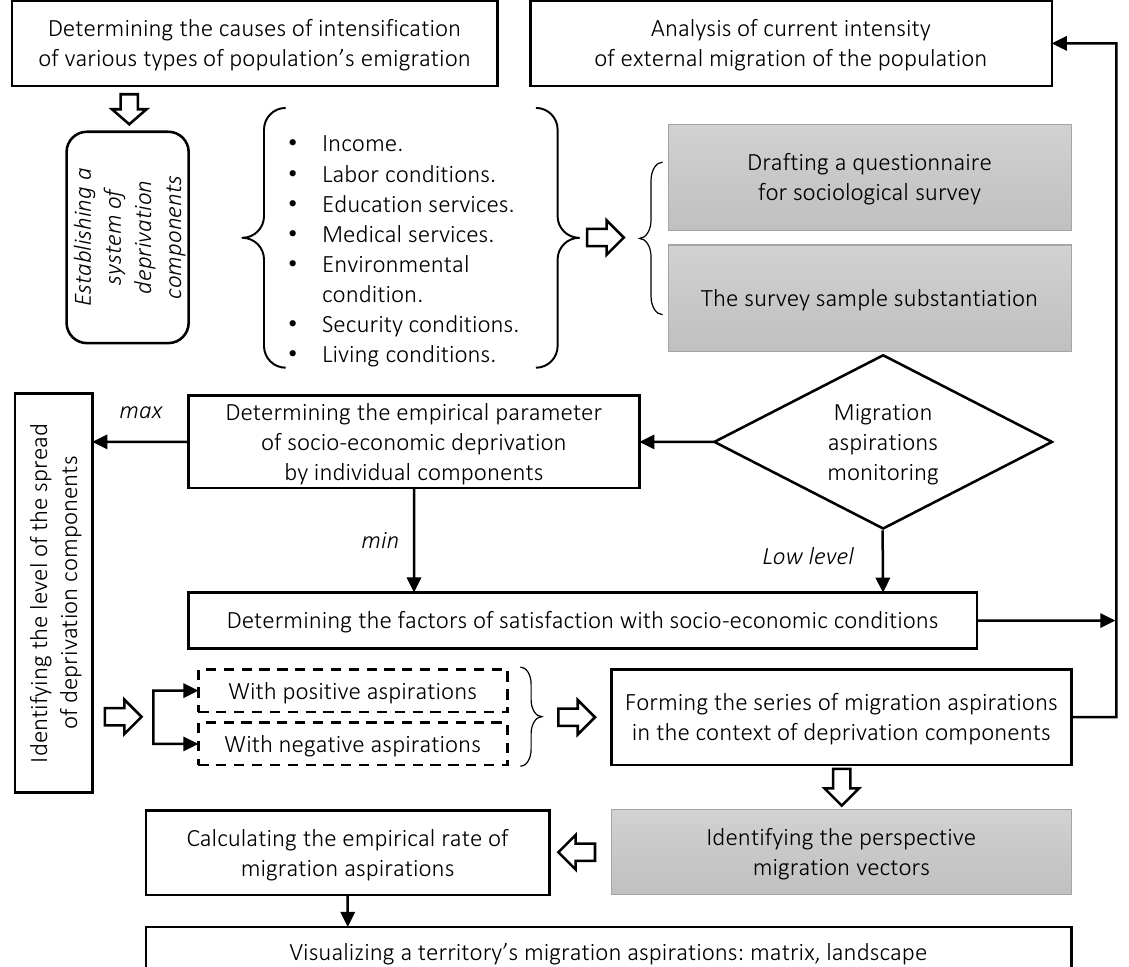
Figure 1. Algorithm of informational-analytical support of the diagnostics of migration